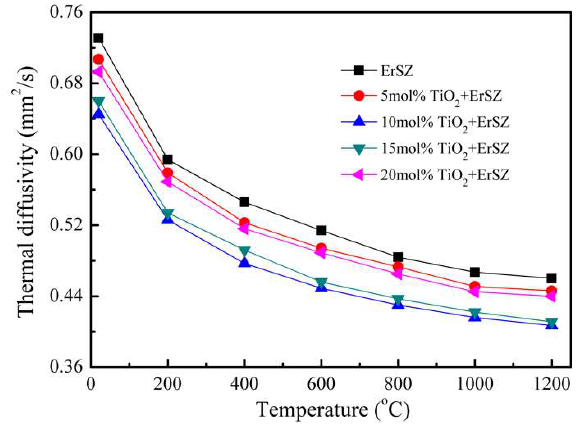
Figure 3. Thermal diffusivities of different amounts of TiO 2 -doped ErSZ.